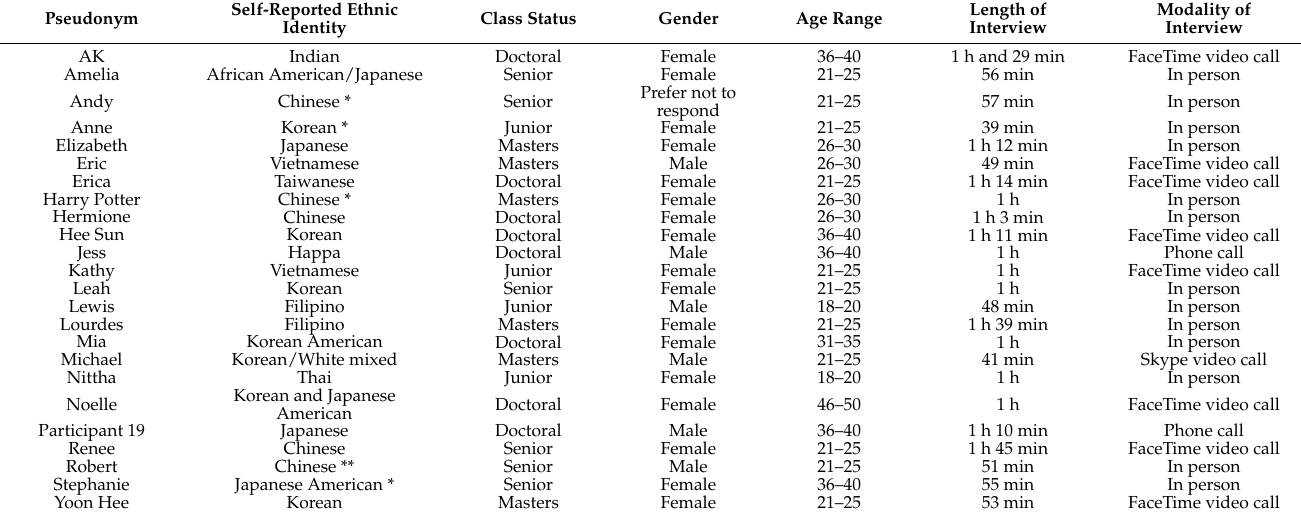
Table 1. Participant Demographic and Interview